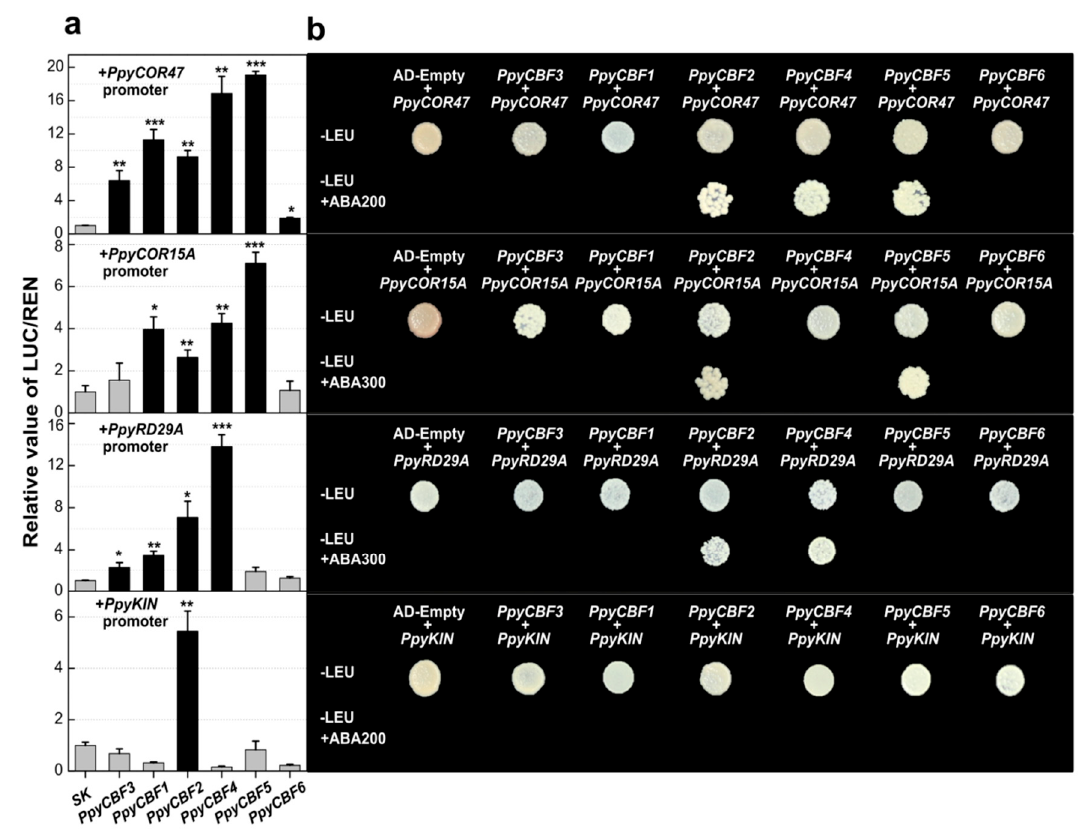
Figure 5. In vivo and in vitro regulations of PpyCBFs on the promoters of stress-related genes. ( a ) Dual luciferase assay to check the in vitro regulations. The ratio of firefly luciferase / renilla luciferase (LUC / REN) of the empty vector (pGreenII 0029 62-SK) plus promoter was used as calibrator (set as 1). Three independent experiments were done to verify the results. Error bars show SEs with at least four biological replicates, while asterisks show significant differences of genes SK with empty SK (* p < 0.05, ** p < 0.01, *** p < 0.001). ( b ) Y1H assay shows in vivo binding of PpyCBFs on PpyCOR